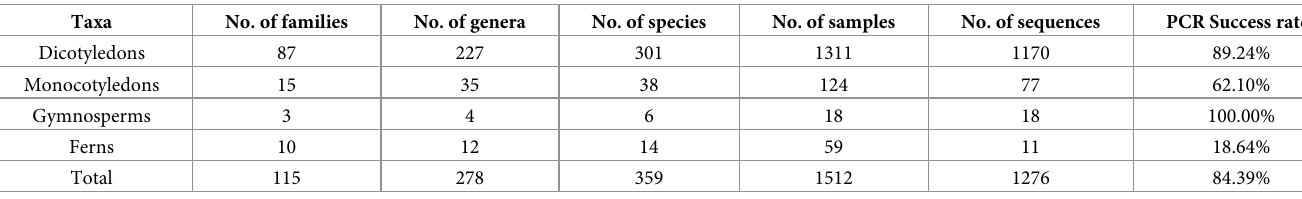
Table 1. PCR success rates of ITS2 in this